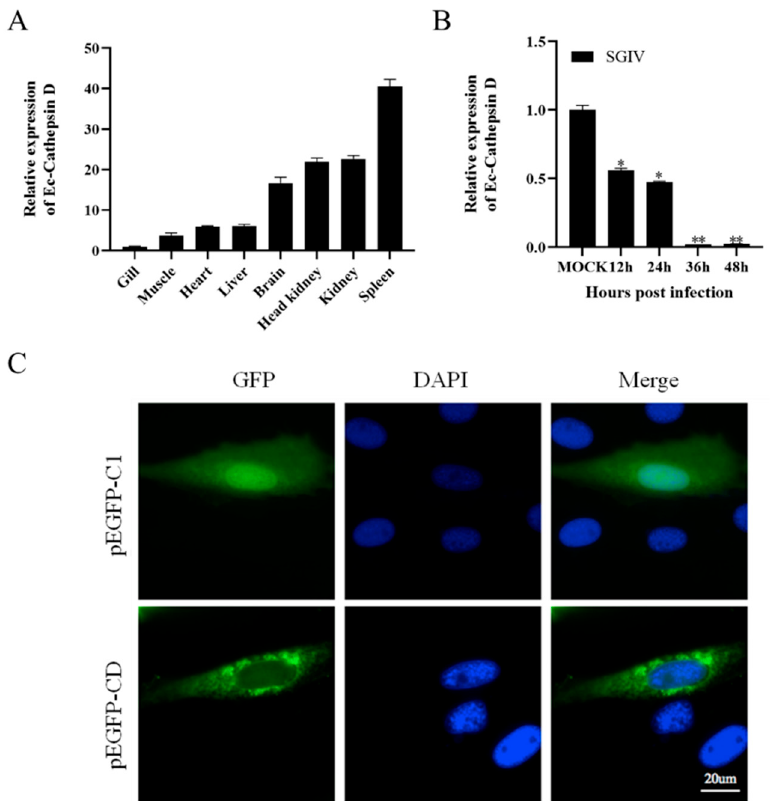
Figure 1. Expression patterns of Ec-CD were determined by qRT-PCR analysis. ( A ) The expression level of Ec-CD in different tissues from healthy groupers. Data are expressed as a ratio to the Ec-CD mRNA expression in gills. ( B ) GS cells were infected with SGIV and the expression level of Ec-CD was analyzed at different time points. β -actin (reference gene) was calculated using the 2 − ∆∆ Ct method. Results are presented as the means ± SD of data from four independent experiments. * p < 0.05, ** p < 0.01. ( C ) Subcellular localization of Ec-CD in grouper cells. PEGFP-C1 and pEGFP-CD were transfected into GS cells. After 24 h, cells were fixed and stained with DAPI and imaged by fluorescence microscopy. Green fluorescence indicated pEGFP-C1 or pEGFP-CD, and blue fluorescence indicated the